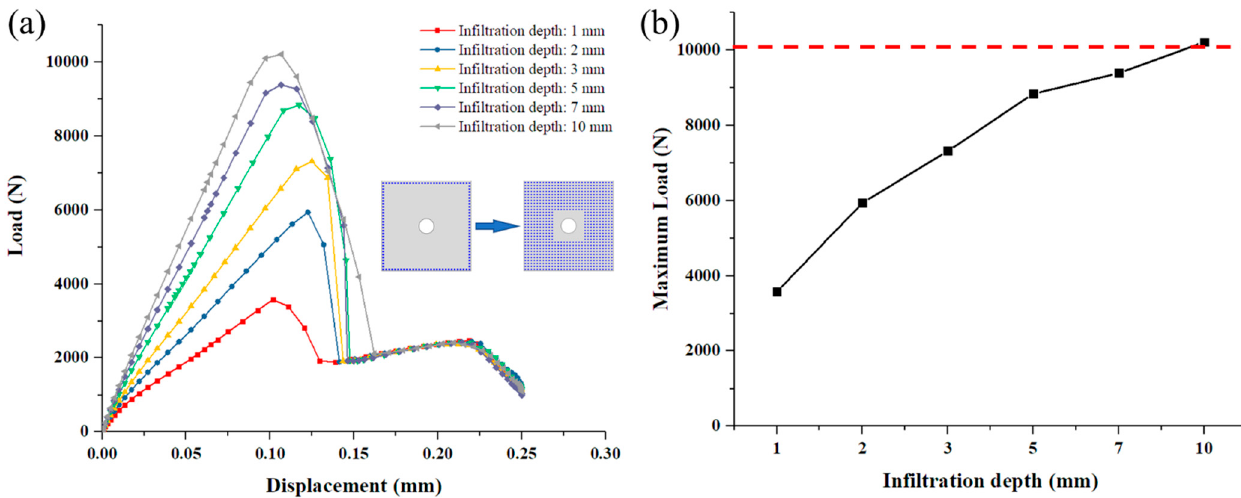
Figure 19. ( a ) Load and displacement curves with different infiltration depths of the deposited SiC matrix in DZA; ( b ) Relationship between the joint’s maximum load and the infiltration depth of the deposited SiC matrix in DZA.